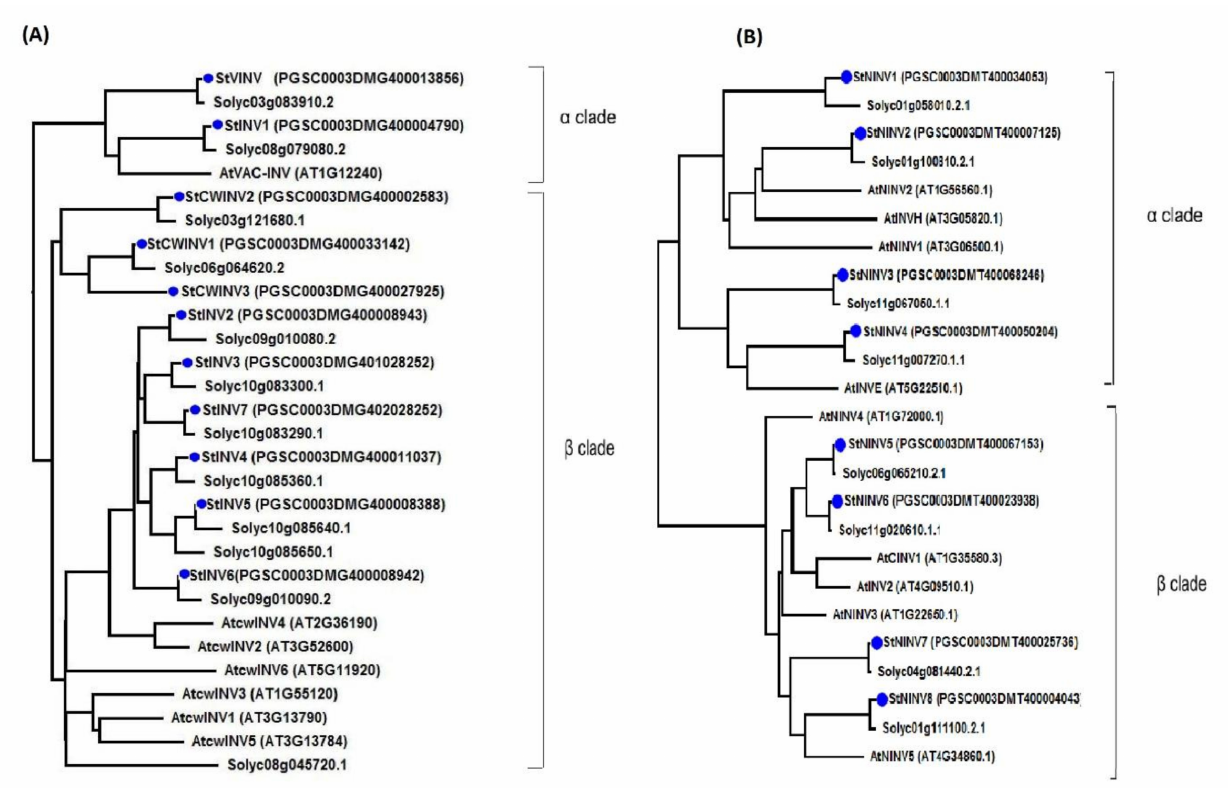
Figure 3. Phylogenetic tree of the acid invertase proteins and neutral/alkaline invertase proteins in Solanum tuberosum . ( A ) The α clade comprises vacuolar invertases, while the β clade is comprised of the cell wall and other members of invertase family. ( B ) The α clade is comprised of neural invertases (PtNINV1-4). The β clade is comprised of neutral invertases